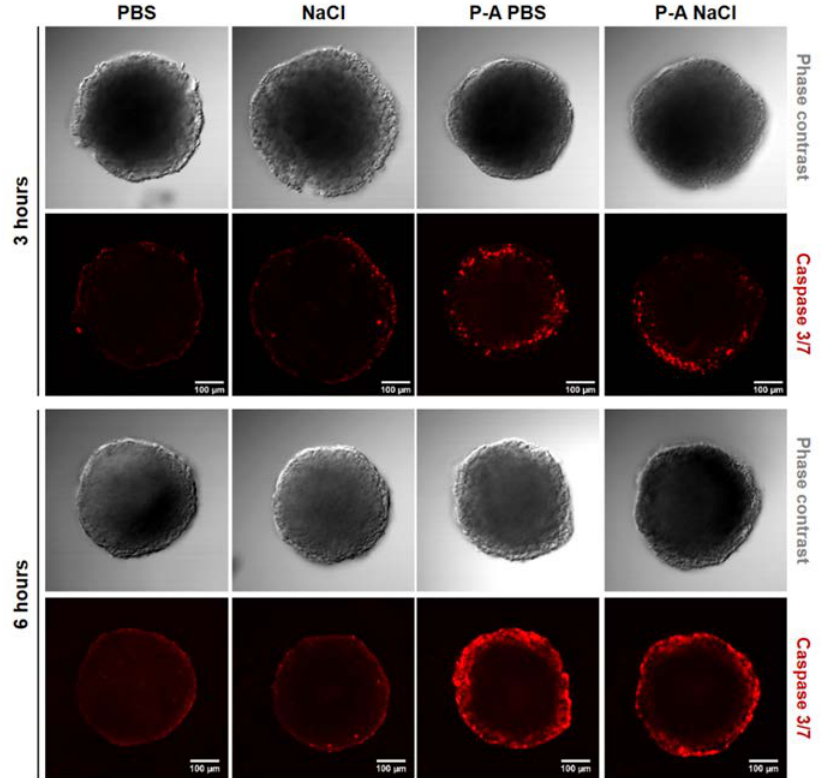
Figure 3. Plasma-activated liquids-induced apoptosis. HCT-116 GFP spheroids were stained with caspase 3/7 red reagent (Molecular Probes Invitrogen, Eugene, Oregon, USA)) 3 or 6 hours after incubation with either PBS or NaCl exposed to plasma-activated PBS and plasma-activated NaCl (P-A PBS or P-A NaCl, respectively). Fixed entire spheroids were imaged with a confocal microscope. Phase contrast and caspase 3/7 micrographs are presented (equatorial z-slice). The emitted light from caspase 3/7 red reagent was collected through a 610–650 nm bandpass filter. PBS and NaCl represented the controls. The scale bar is set at 100 µm.